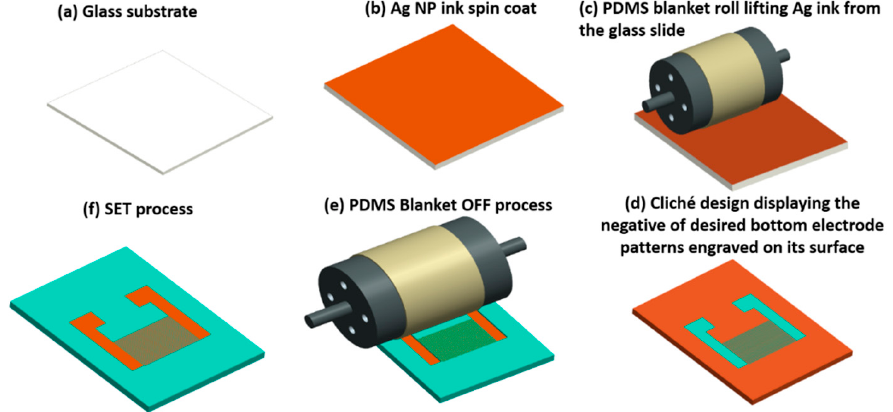
Figure 2. Schematic illustration of reverse-offset printing of Ag IDTs on glass substrate.